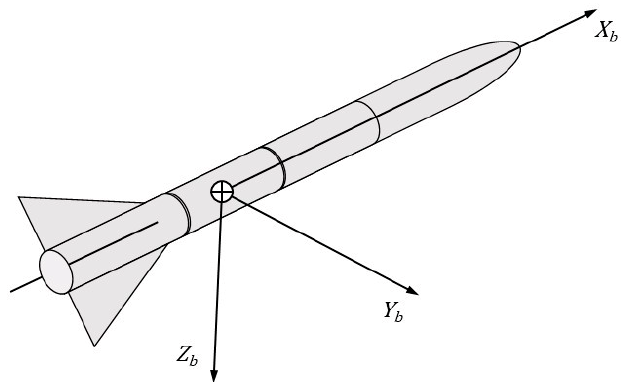
Figure 3. Adopted rocket body axes reference frame.